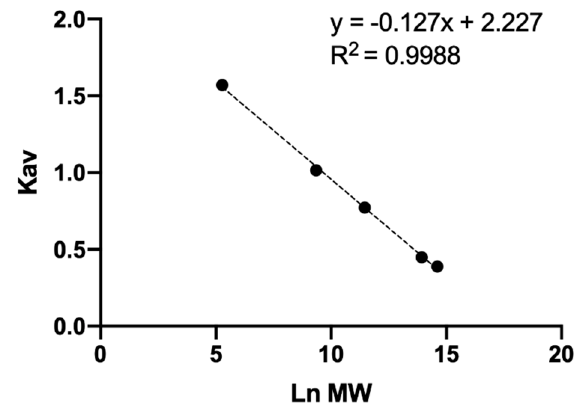
Figure 1. Analytical curve of molecular weight of HA.